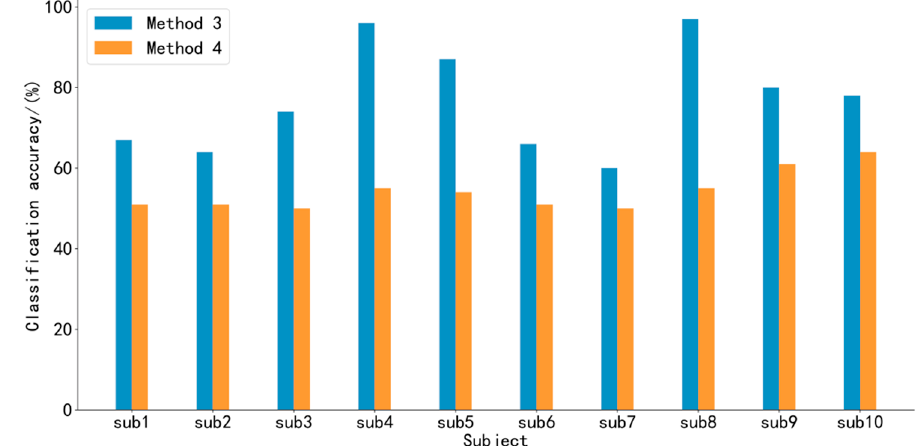
Figure 8. Classification accuracy comparison of Method 3 and Method 4.